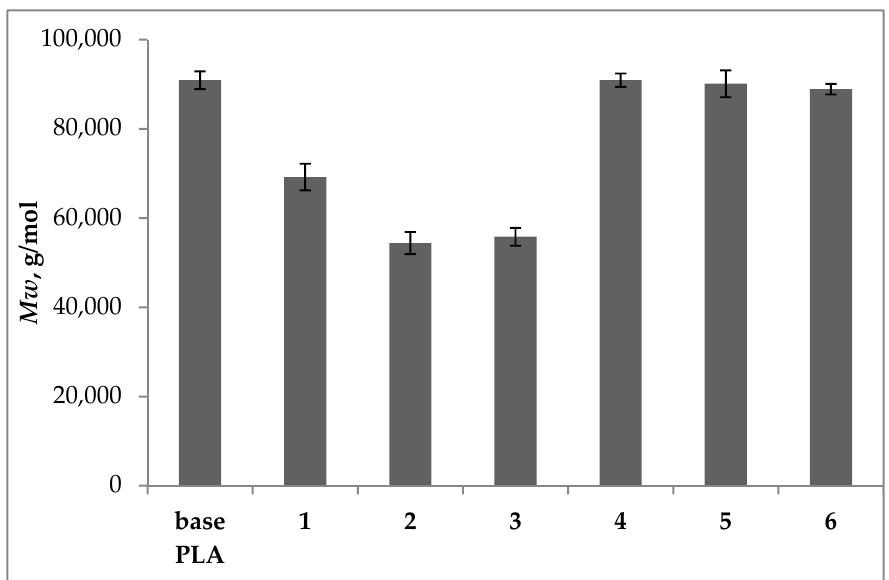
Figure 4. M w of base and plasticized PLA determined by MALS detector.